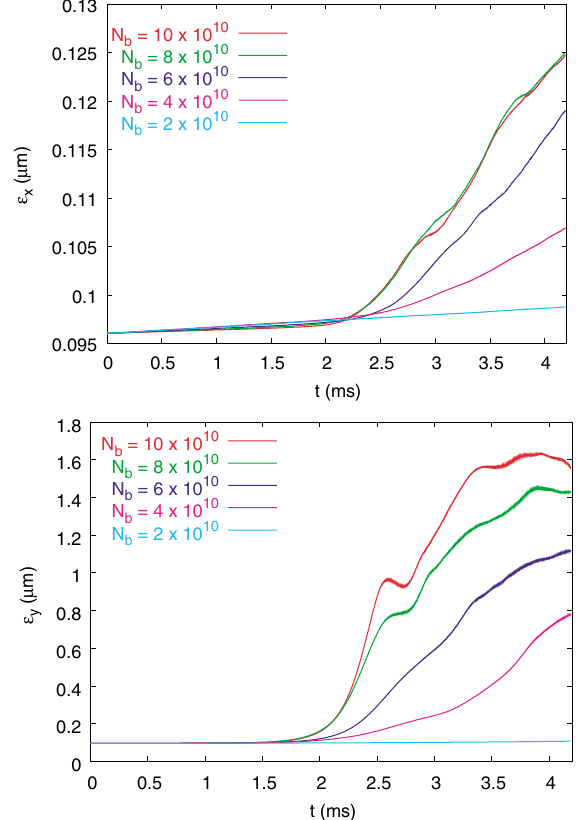
FIG. 11. (Color) Horizontal (upper panel) and vertical (lower panel) emittance growth over 2000 turns for different bunch intensities and zero chromaticity (different vertical scales are used in the two pictures).